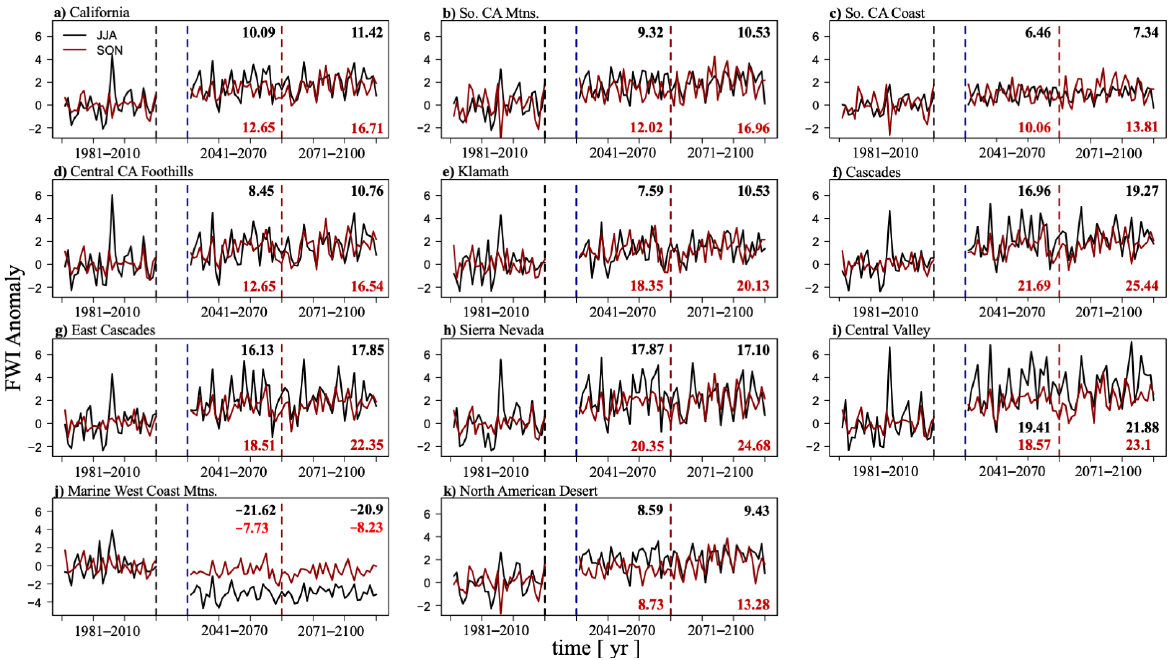
Figure 4. Canadian Fire Weather Index anomaly relative to the historical period of 1981–2010. Solid black line represents the summer season of June, July, and August, while the solid red line represents the fall season of September, October, November. The dashed vertical black line represents the end of the historical period, while the dashed vertical blue and red lines represent the breaks between the mid- and late-century periods, respectively. The black and red text within the figure is the relative change (%) for the mid- and late-century periods (relative to the historical period) in the JJA and SON seasons, respectively. ( a ) California; ( b ) Southern California Mountains; ( c ) Southern California Coast; ( d ) Central California Foothills; ( e ) Klamath; ( f ) Cascades; ( g ) East Cascades; ( h ) Sierra Nevada; ( i ) Central Valley; ( j ) Marine West Coast Mountains; ( k ) North American Desert.